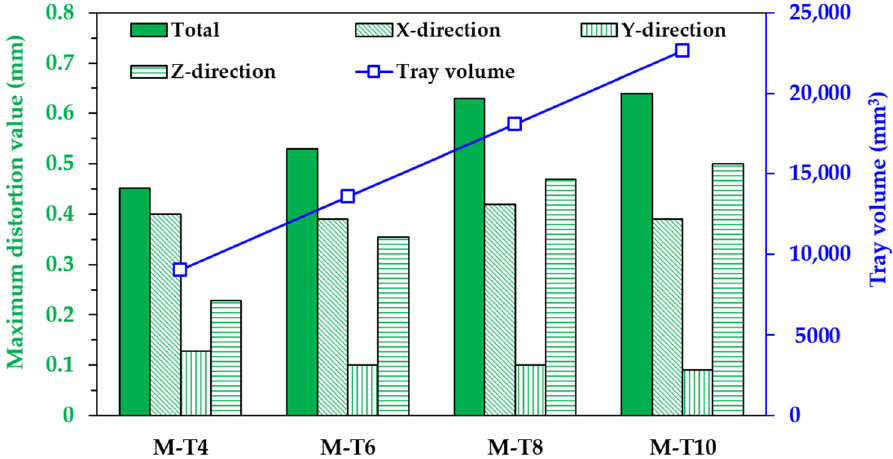
Figure 13. The maximum distortion of the as-built tibial component with different tray thickness.